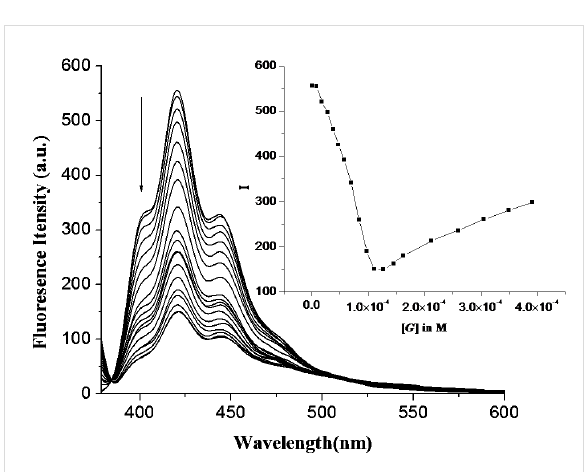
Figure 2: Energy optimized geometry of 1 with H 2 PO 4 − ( E = 92.14 kcal/mol, a = 2.45 Å, b = 1.94 Å, c = 2.34 Å, d = 2.82 Å).